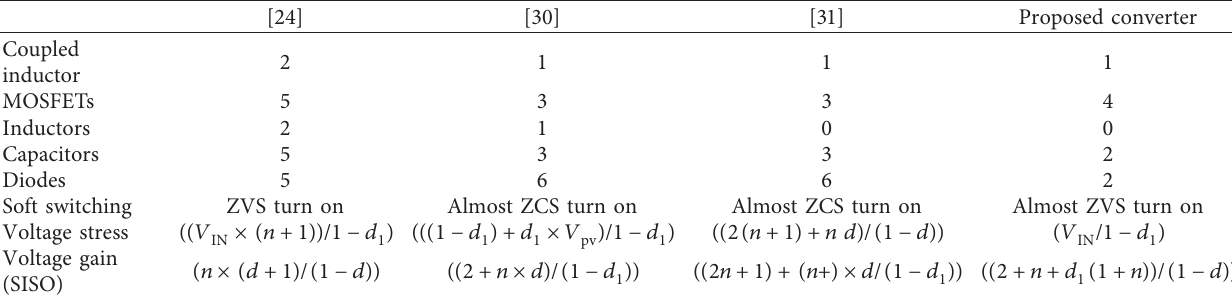
Table 5: Comparative analysis of proposed converter with latest benchmarks converters.